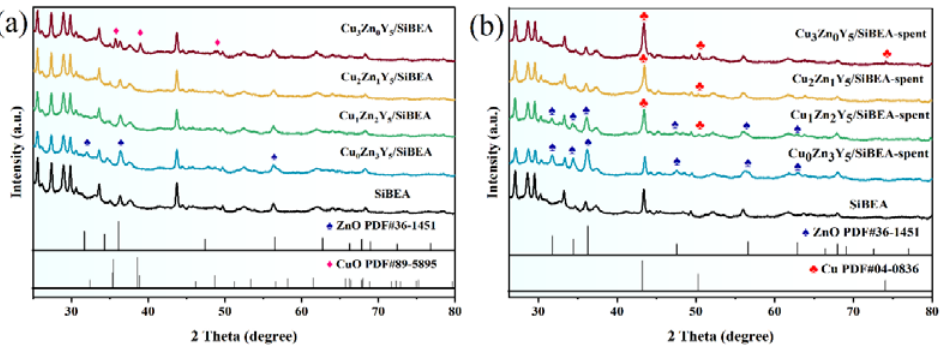
Figure 1. XRD patterns of ( a ) the fresh CuZnY/SiBEA catalysts and ( b ) the spent CuZnY/SiBEA catalysts. The XRD results of spent catalysts are shown in Figure 1b. The BEA topological structures are well preserved for all samples after the ETB reaction, indicating that the SiBEA carriers have excellent hydrothermal stability without framework collapse in the ETB reaction. The characteristic peak of ZnO in the spent Cu 0 Zn 3 Y 5 /SiBEA is more evident than in the fresh catalyst. In addition, no characteristic peaks of ZnO are found in the fresh Cu 1 Zn 2 Y 5 /SiBEA, but they appear in the corresponding spent catalyst. These results imply that some zinc ions are gradually separated from the zeolite matrix to form zinc oxide clusters during the ETB reaction. This observation is consistent with Yuan group’s literature [20], in which Zn species accommodated in the vacant T-atom sites of zeolite, after heat treatment for a time, produced small ZnO nanoclusters. For all copper-containing catalysts, the crystal phase of copper oxide disappears after the reaction, and the characteristic peaks of metallic copper appear at 43.3, 50.4, and 74.1 ◦ instead. This suggests that copper oxide clusters outside the zeolite framework could be reduced to metallic copper particles [16,21]. Significantly, no characteristic peaks of yttrium oxide or metallic yttrium have been found in the XRD patterns, either fresh or spent catalysts, indicating that Y(III) species are very stable during the ETB conversion. The nature of the surface Cu, Zn, and Y species in the fresh and spent Cu 0 Zn 3 Y 5 /SiBEA and Cu 3 Zn 0 Y 5 /SiBEA catalyst is further studied by X-ray photoelectron spectroscopy (XPS) as shown in Figure 2. The XPS spectrum in the Zn 2p region (Figure 2a) of the fresh Cu 0 Zn 3 Y 5 /SiBEA catalyst exhibits a main Zn2p 3/2 band at a binding energy of about 1022.9 eV and a less intense Zn 2p1/2 signal at 1046.1 eV. The Zn 2p binding energy of the Cu 0 Zn 3 Y 5 /SiBEA sample is higher than bulk zinc oxide, attributed to highly dispersed Zn(II) species strongly interacting with the SiBEA zeolite matrix to construct Zn-O-Si bonds [18,20,22]. After the ETB reaction, no additional signals are found, indicating that the chemical state of zinc does not change. However, an apparent decline in the Zn signals occurs for the spent Cu 0 Zn 3 Y 5 /SiBEA catalyst, hinting at the partial coverage of the Zn species by coke compounds